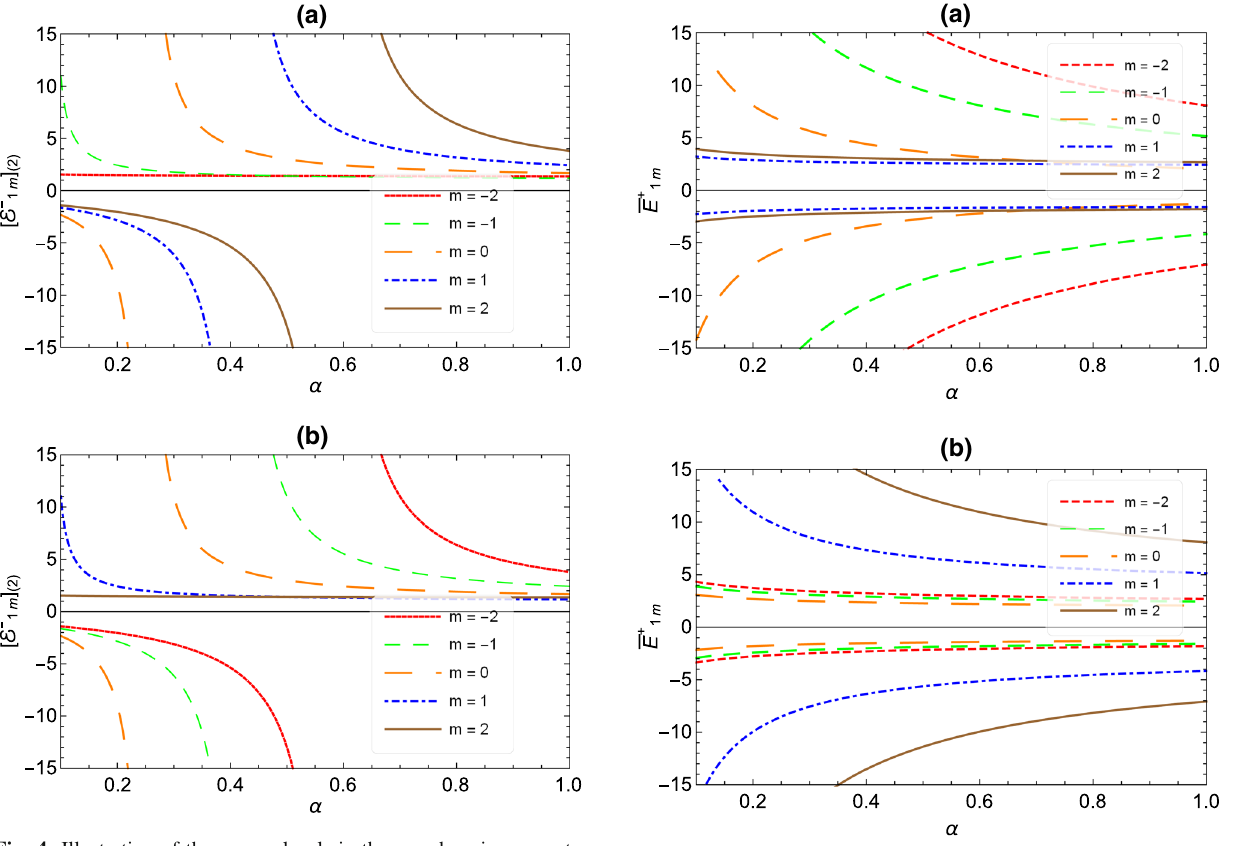
Fig. 5 The energy ¯ E + as a function of the parameter α . a s = 1, b 1 m s = − 1. We use M = 1 and η L = 1. In a the plot for s = 1 and b for s = − 1. We see clearly that the spectrum of the states are